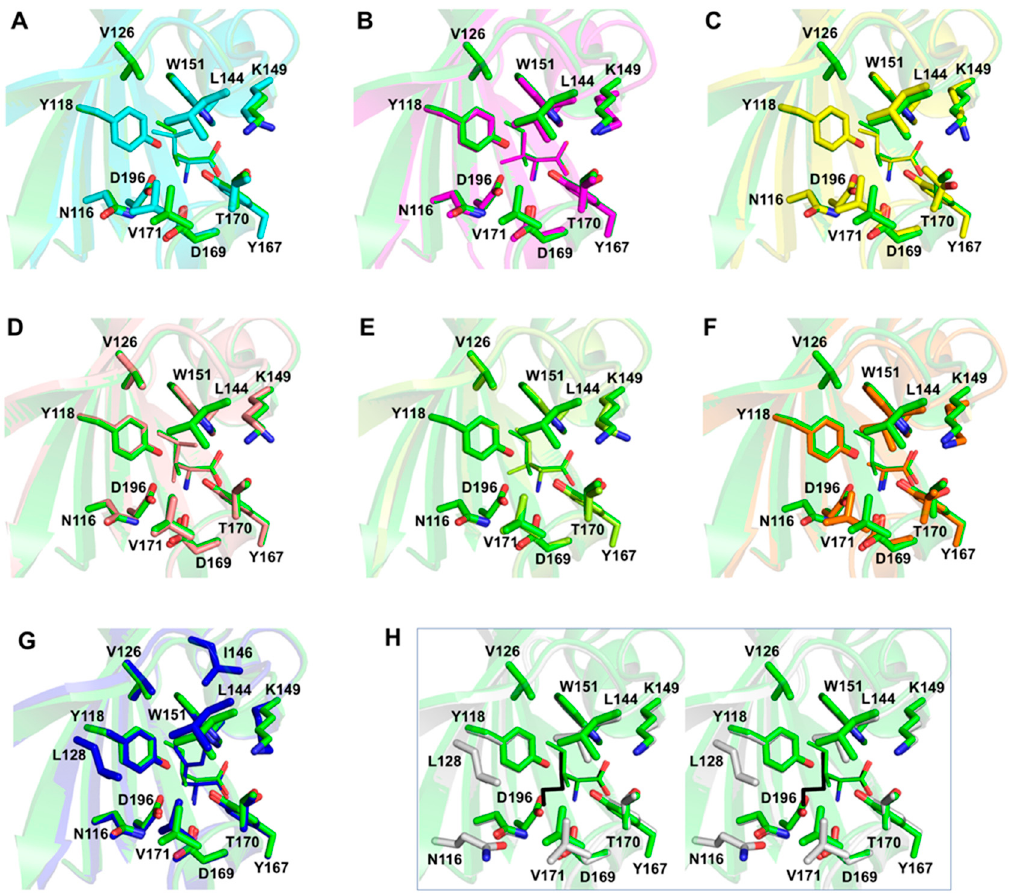
Figure 7. Ribbon diagram of Tlp3 LBD/isoleucine complex (green, PDB ID 4XMR) superimposed on Tlp3 LBD complexes with ( A ) leucine (cyan), ( B ) valine (magenta), ( C ) α -amino-N-valeric acid (yellow), ( D ) 4-methyl-L-isoleucine (salmon), € 3-methyl-L-isoleucine (lime), ( F ) alanine (orange), ( G ) phenylalanine (blue), and ( H ) β -methyl-L-norleucine (the latter in stereo; protein, white/black for protein/ligand). The diagram illustrates a similar mode of ligand binding. The ligands and the protein residues they contact in their respective complexes are shown in thin and thick stick representation, respectively.